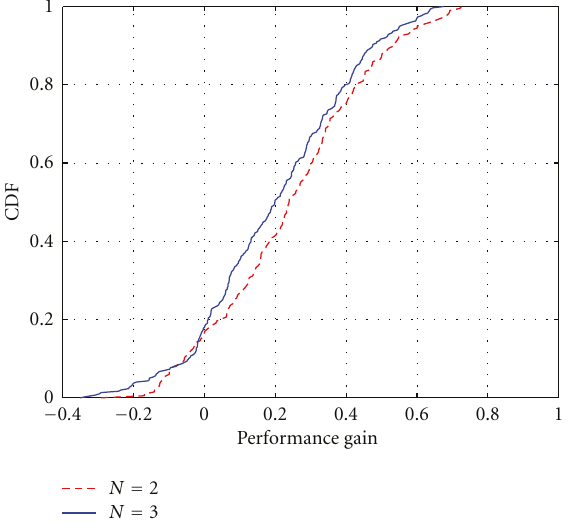
Figure 14: CDF of performance gain when the system state is fully observable and the channel rewards change with time.